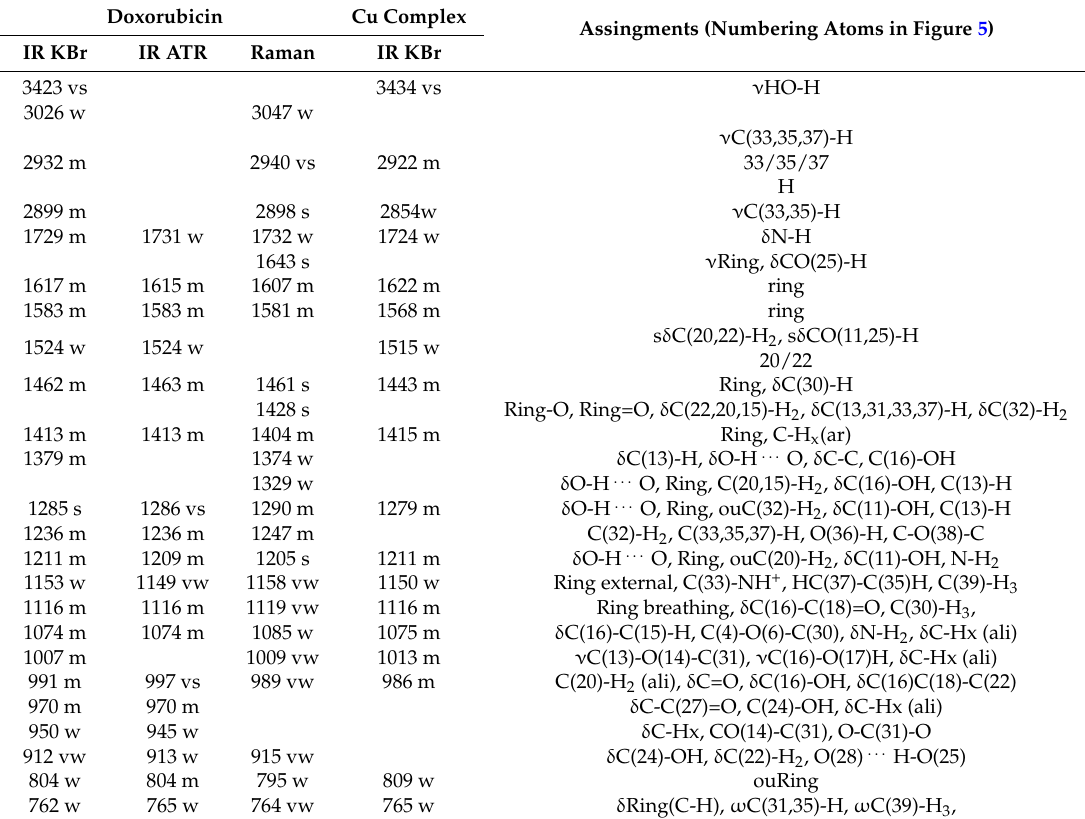
Table 2. Wavenumbers (cm − 1 ), intensities and assignments of bands occurring in the IR (KBr, ATR) and Raman spectra of DOX hydrochloride and IR spectra for Cu-DOX complex. Doxorubicin Cu